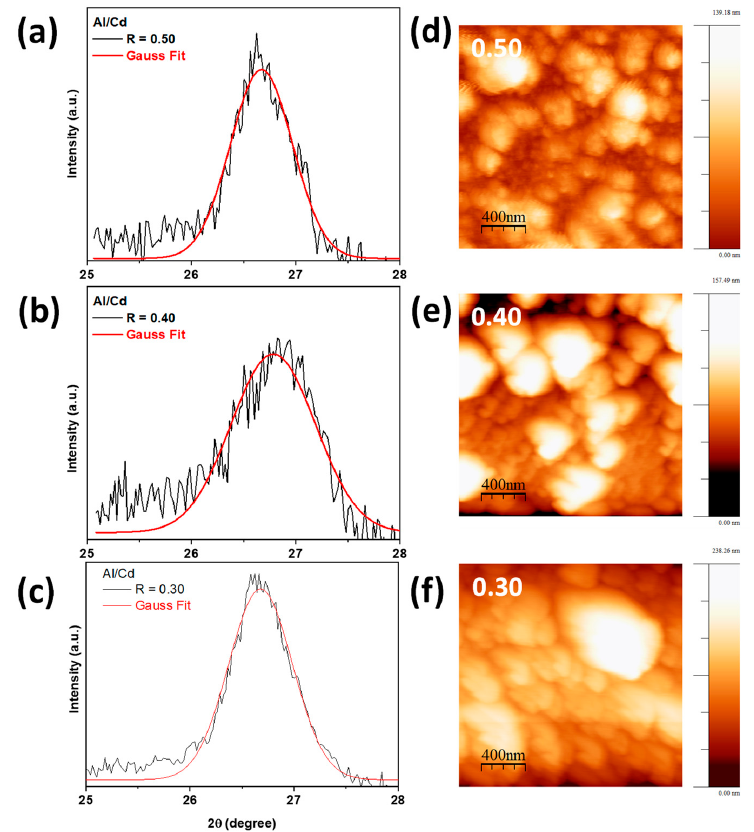
Figure 1. ( a – c ) (002) XRD plane and Gaussian fi t, and ( d – f ) 2D AFM images of thin fi lms grown at R = [Al 3+ ]/[Cd 2+ ] = 0.30, 0.40, 0.50 ratio. R = [Al 3+ ]/[Cd 2+ ] = 0.30, 0.40, 0.50